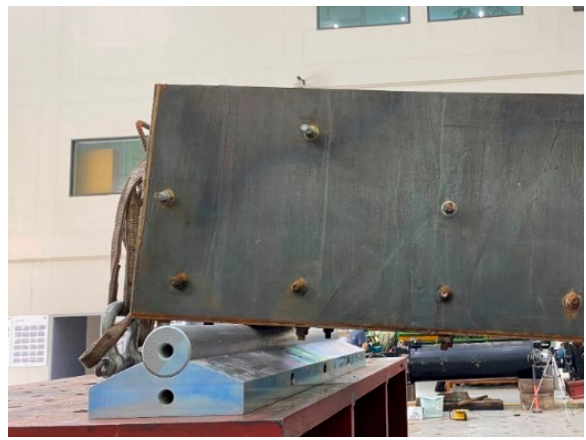
Figure 13 . 2. Load-Deflection Relationship.